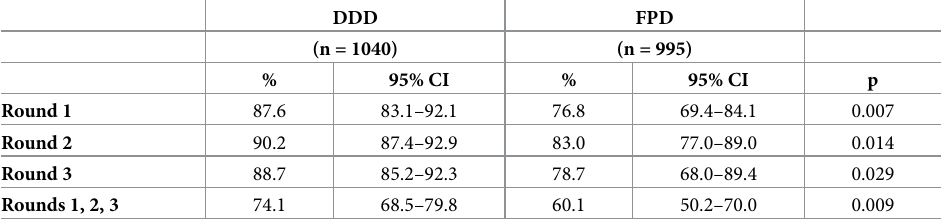
Table 2. Coverage of SMC defined as the proportion of children who received all three days of SMC treatment according to the method of delivery (door to door versus fixed point) in 2014. DDD